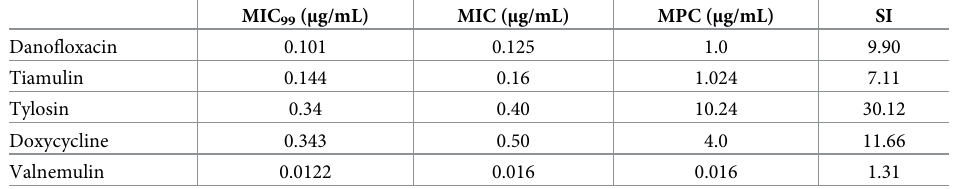
Table 1. Comparison of MIC 99 , MIC, MPC, and SI values for five antimicrobial agents tested against M . hyopneumoniae .